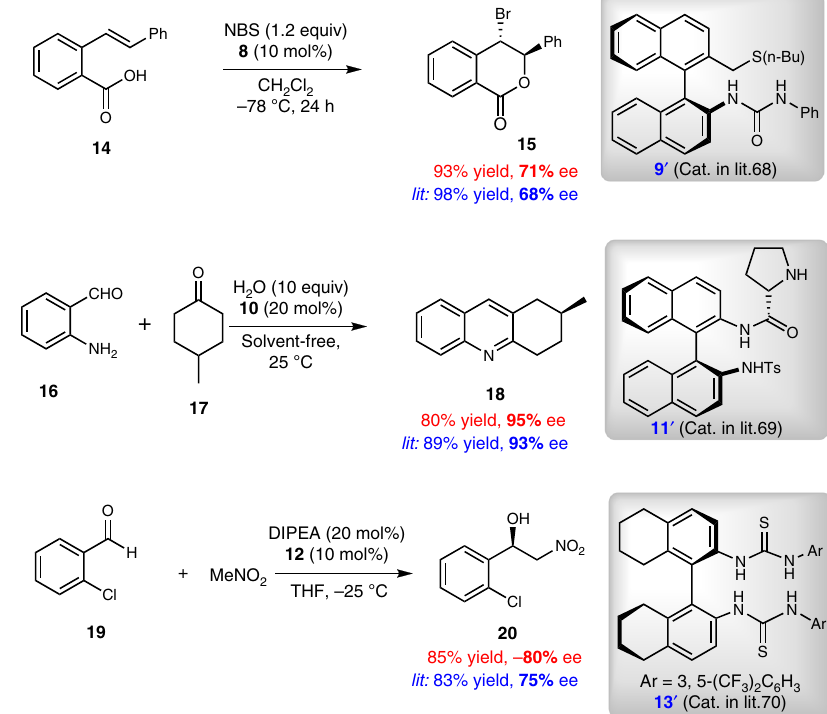
Fig. 6 Product application. Initial attempts for unsymmetrical axially chiral bifunctional